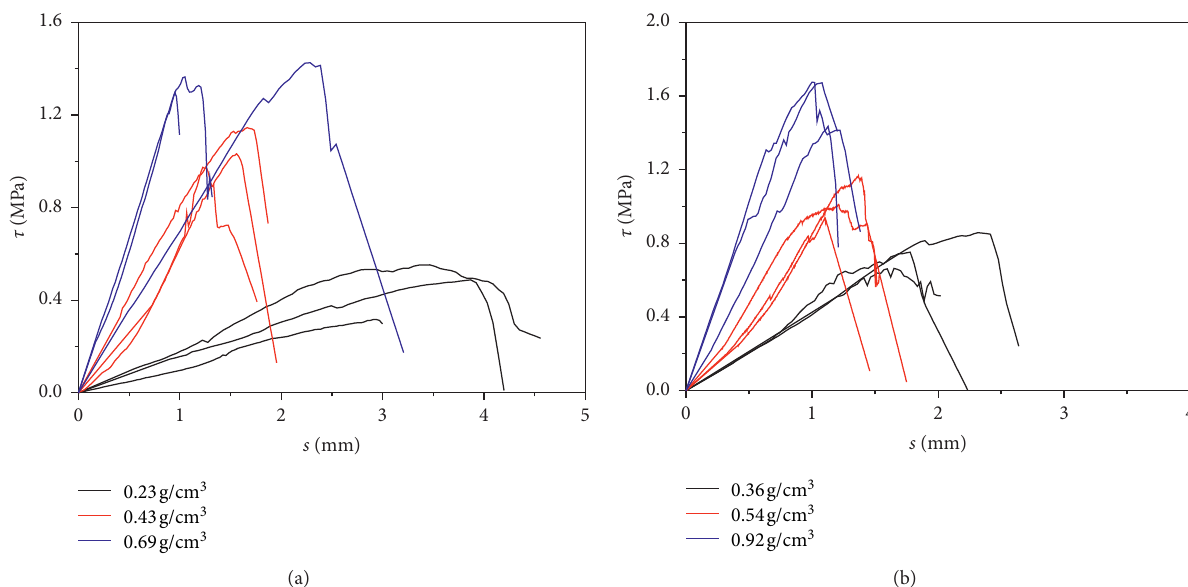
Figure 8: The stress-slip curves of specimens under different polymer density. (a) 0.23, 0.43, and 0.69g/cm 3 ; (b) 0.36, 0.54, and 0.92 g/cm 3 .